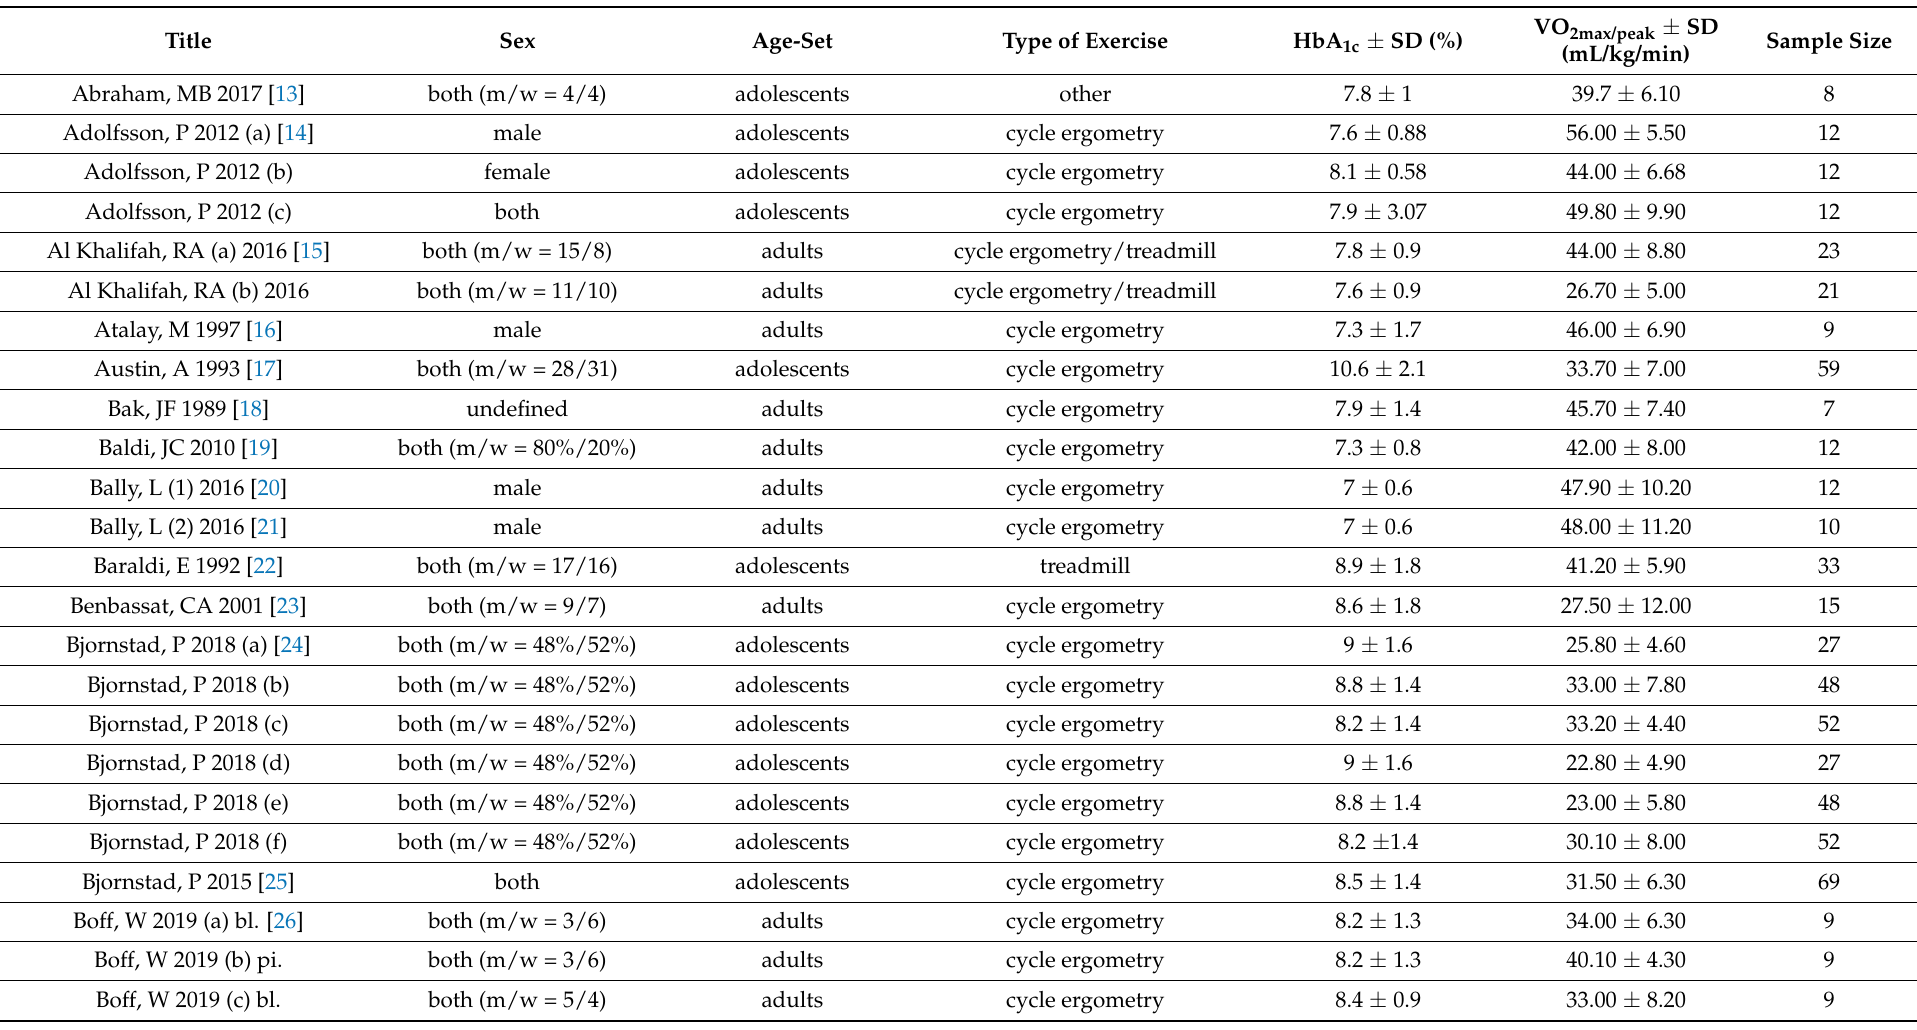
Table 1. Studies included in systematic review and meta-analysis with HbA 1c and VO 2max